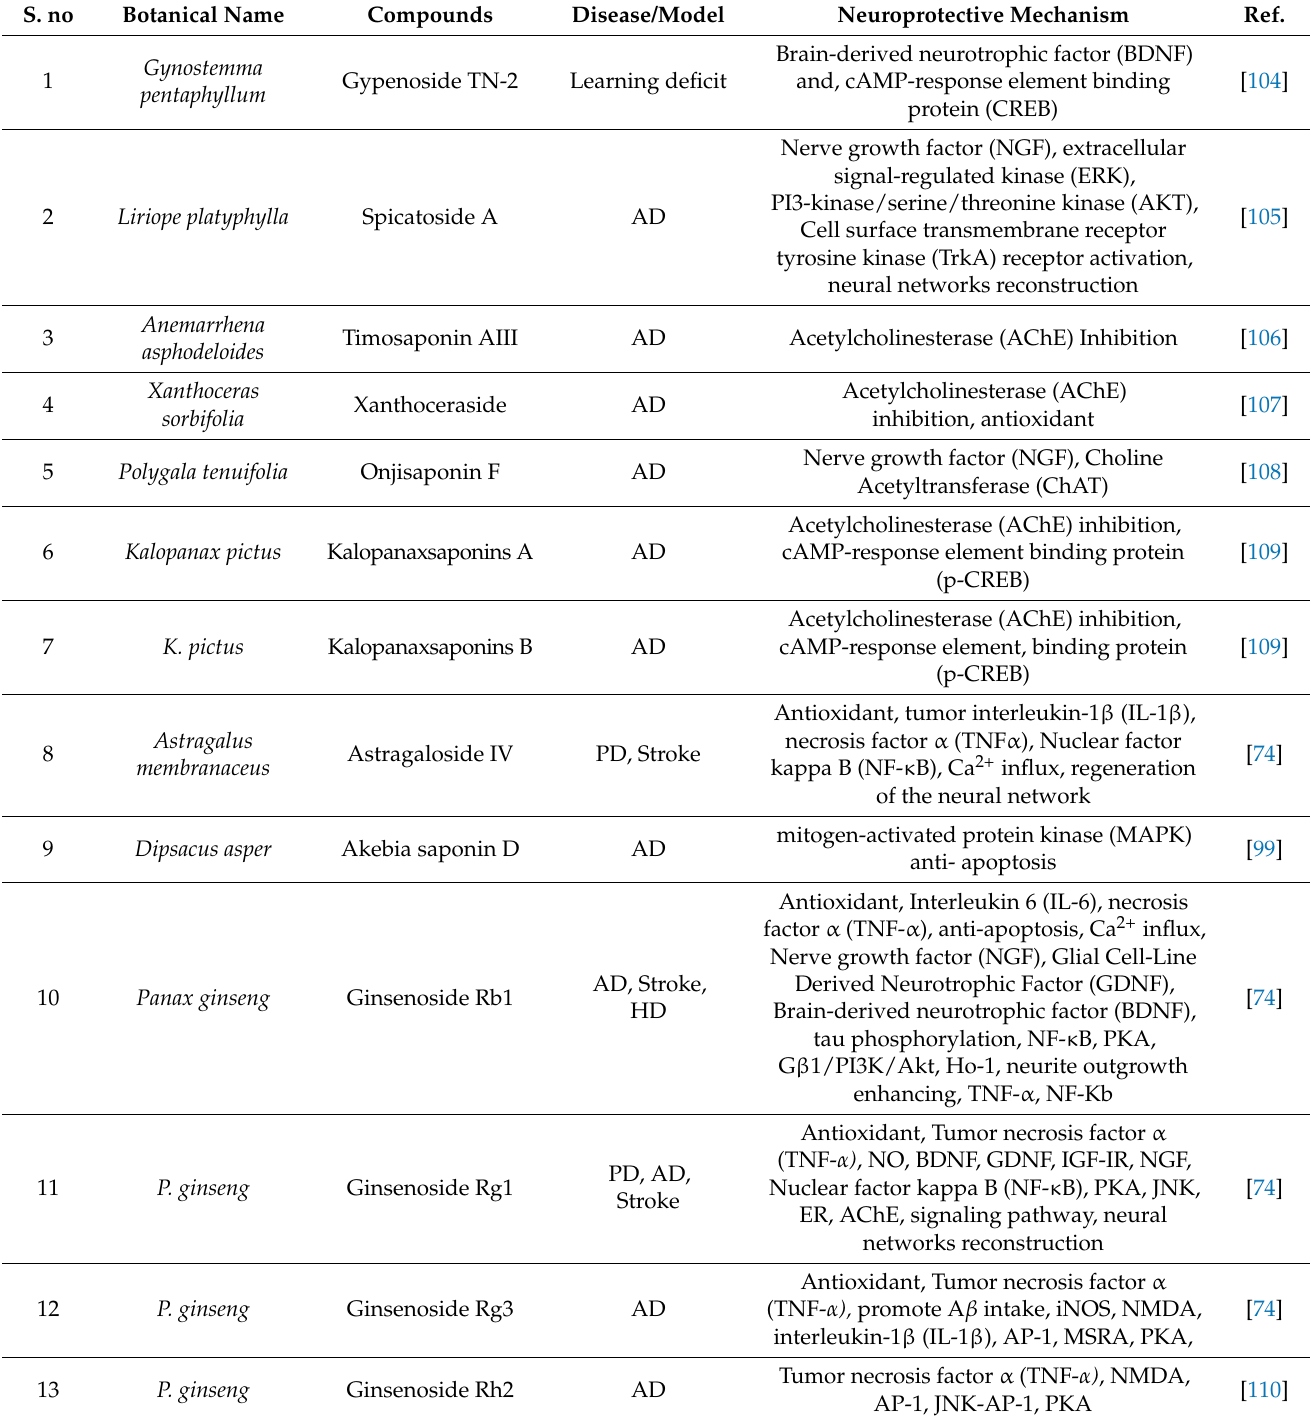
Table 1. Sources, bioactives and underlying neuroprotective mechanisms of